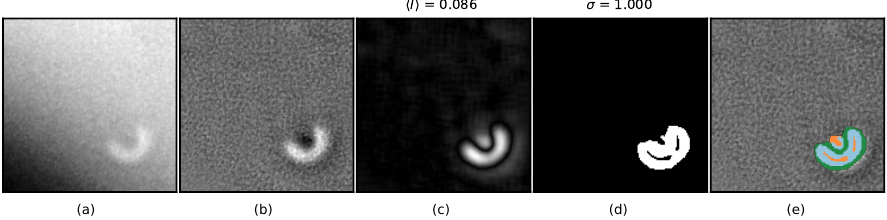
Figure 7. Results for the synthetic partial circle inclusion test dataset. ( a ) is input, ( b ) is the residual image, residual analysis kernel results are for average kernel in ( c ) and standard deviation in ( d ). Above the patch is the maximum value indicated. Kernels above thresholds are indicated in ( e ) with blue ( (cid:104) I (cid:105) and σ ), green ( σ ), and orange ( (cid:104) I (cid:105) ).